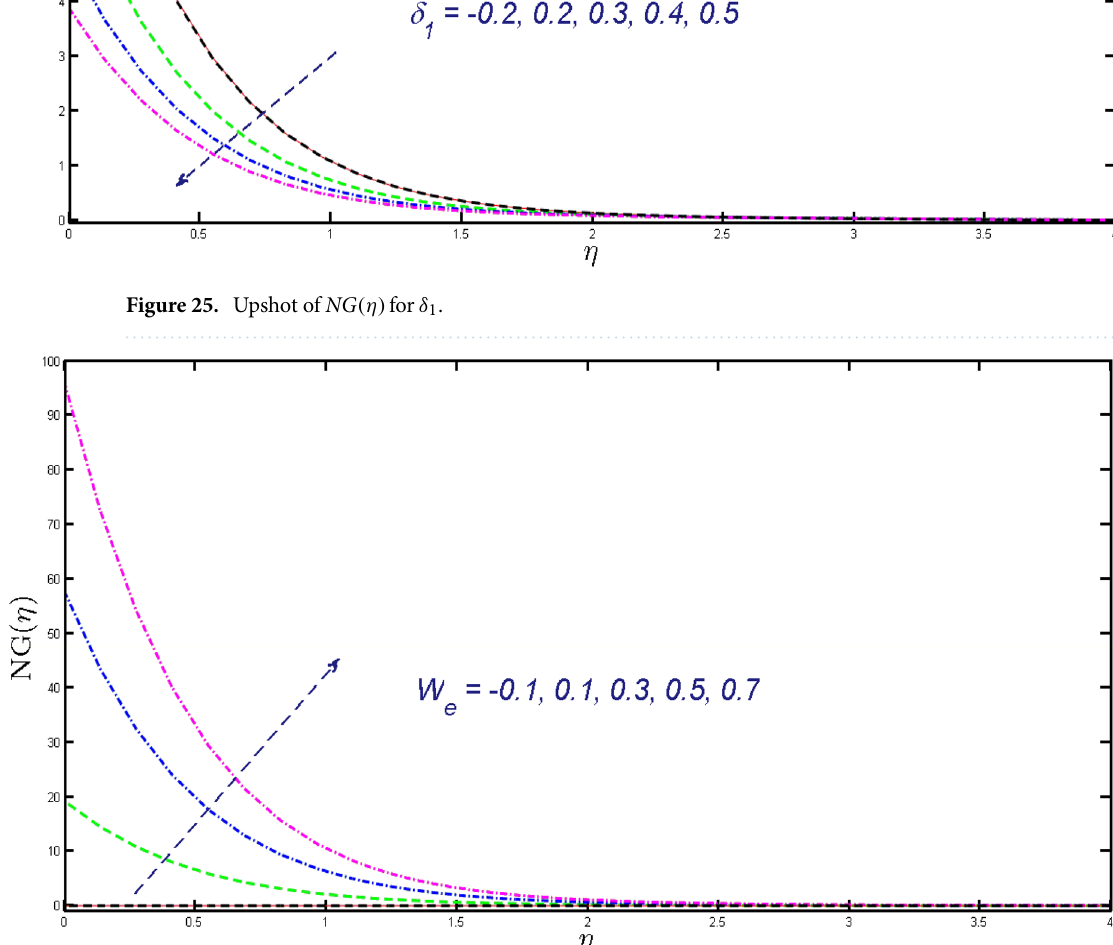
Figure 26. Profile of NG (η) for W e